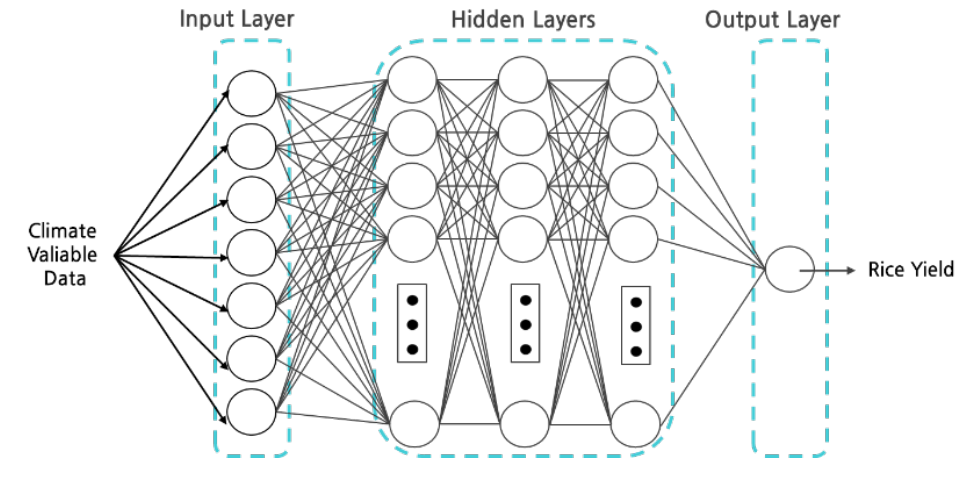
Figure 3. Structure of deep neural network